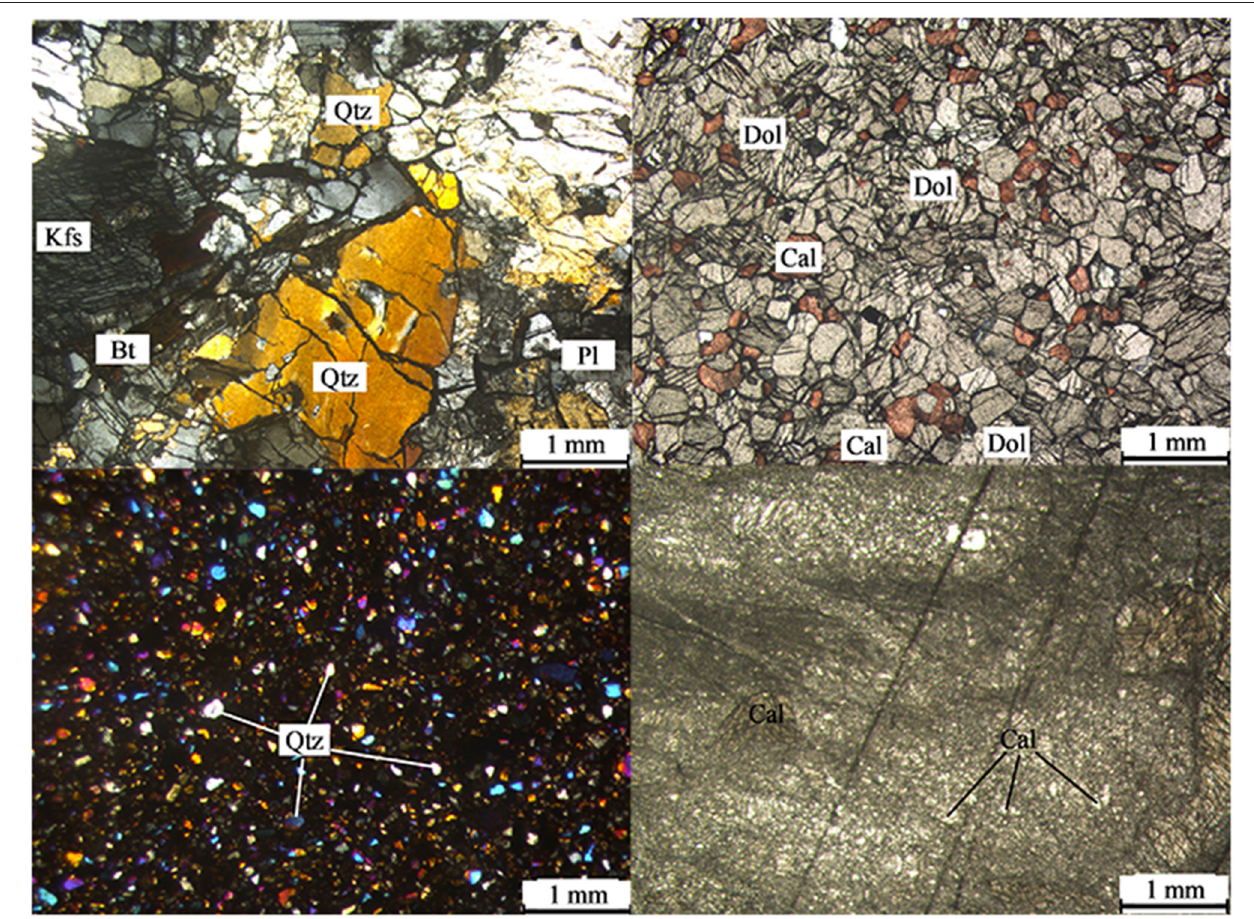
FIGURE 1 | The microstructure of rocks in transparent refractive index experiment, granite (top left), marble (top right), sandstone (bottom left), and limestone (bottom right) (Qtz, quartz; Kfs, k-feldspar; Bt, biotite; PI, plagioclase; Dol, dolomite; Cal, calcite) [